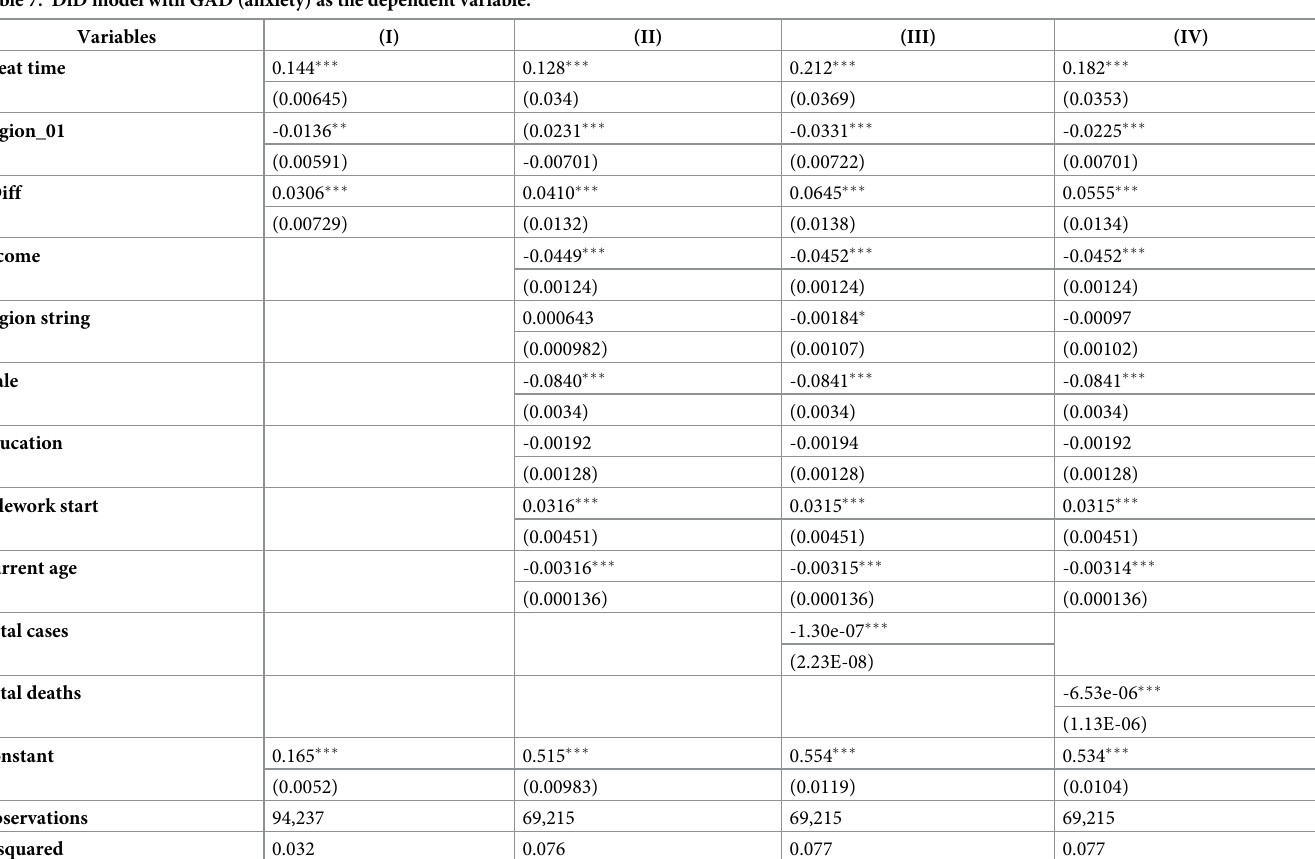
Table 7. DiD model with GAD (anxiety) as the dependent